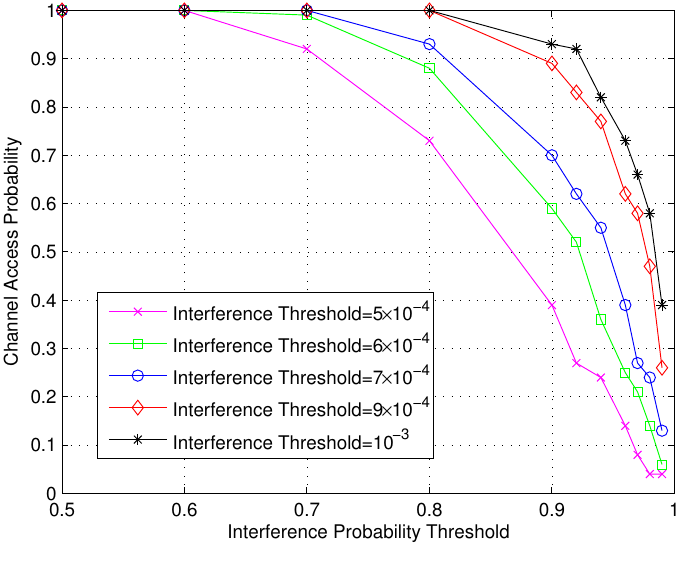
Figure 8. Channel access probability vs. interference probability threshold for different interference thresholds.